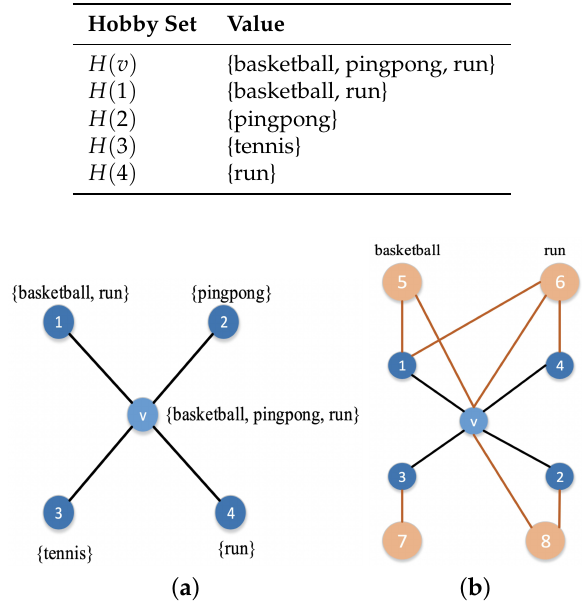
Table 2. The hobby sets of nodes v , 1, 2, 3, and 4.